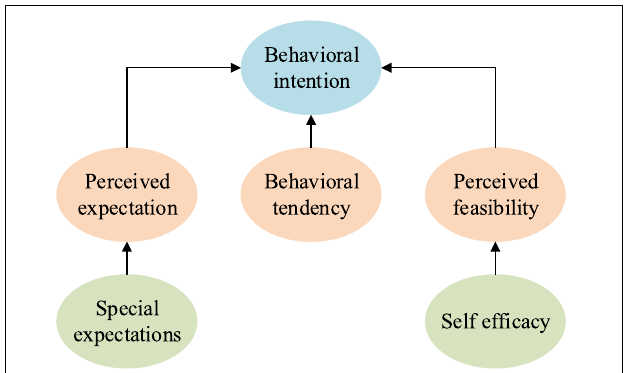
FIGURE 4 | Influencing factor model of college students’ entrepreneurial